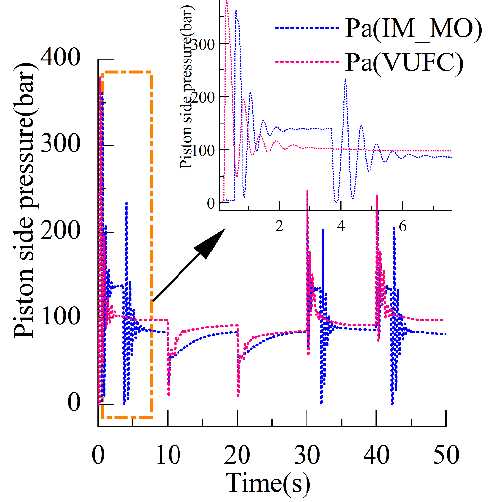
Figure 17. Piston-side pressure.